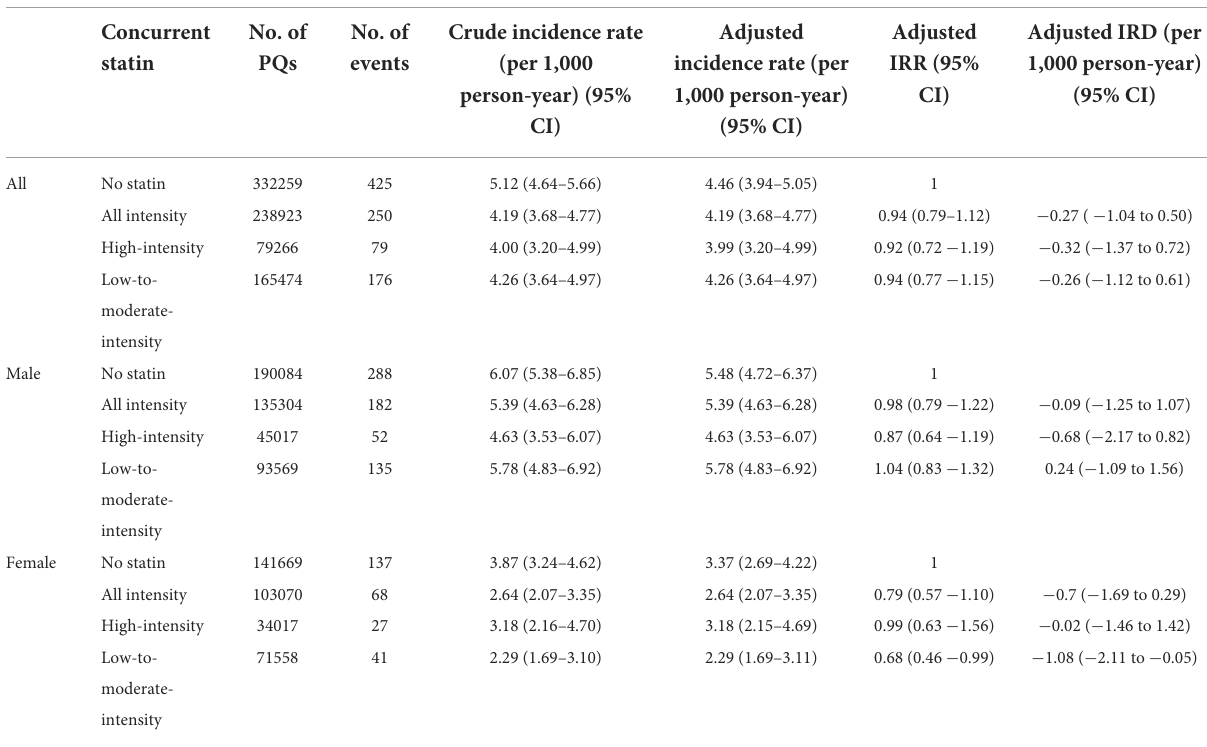
TABLE 5 Genitourinary tract bleeding among DOAC using patients.